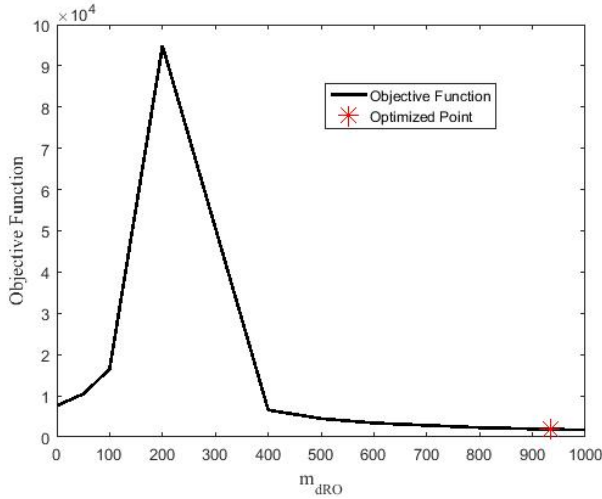
Figure 11. Variations in the objective function with the desalinated water from RO.